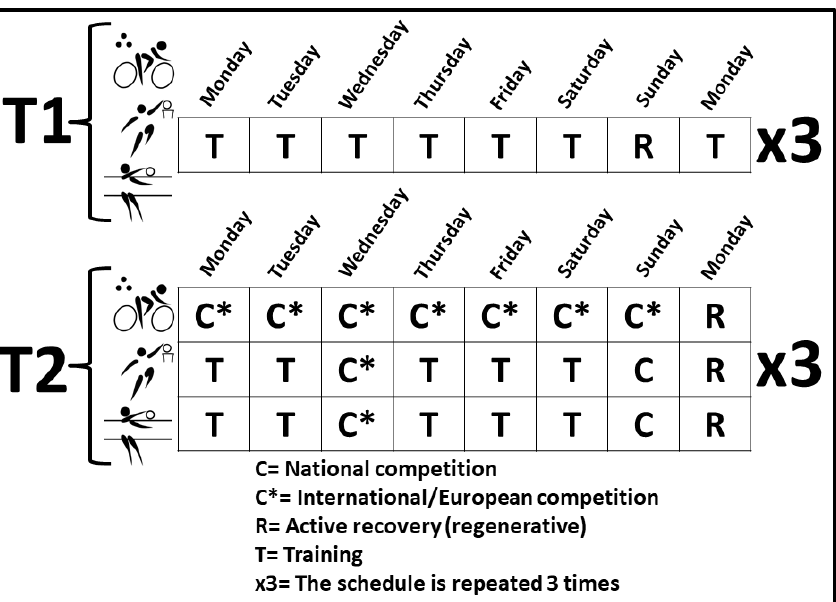
Figure 1. Timeline of events during the study in the 3 sport disciplines. Matches for basketball and volleyball are scheduled according to the coordinated program made by all European Federations.